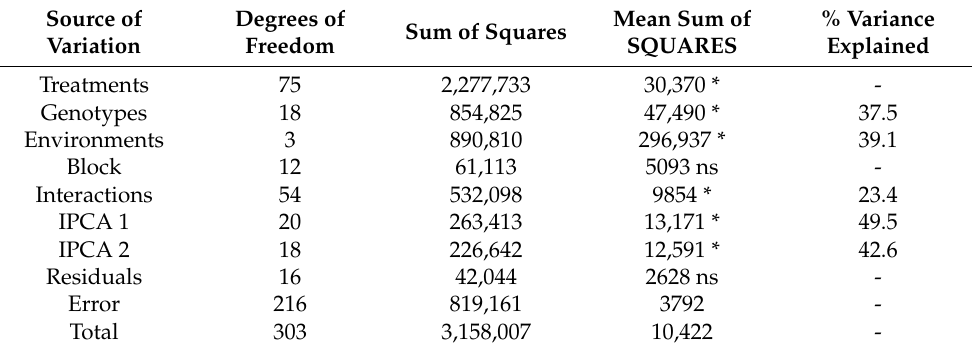
Table 5. Additive main effects and multiplicative interaction (AMMI) analysis of variance of black Sigatoka severity (AUDPC) of Matooke hybrids (NARITAs) and banana varieties evaluated in four environments of Uganda and